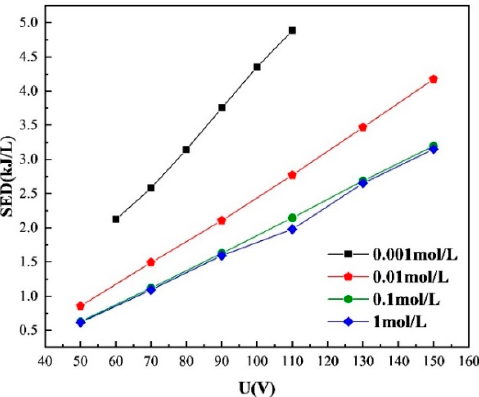
Figure 6. The variation of energy density with input voltage at different solution concentrations.